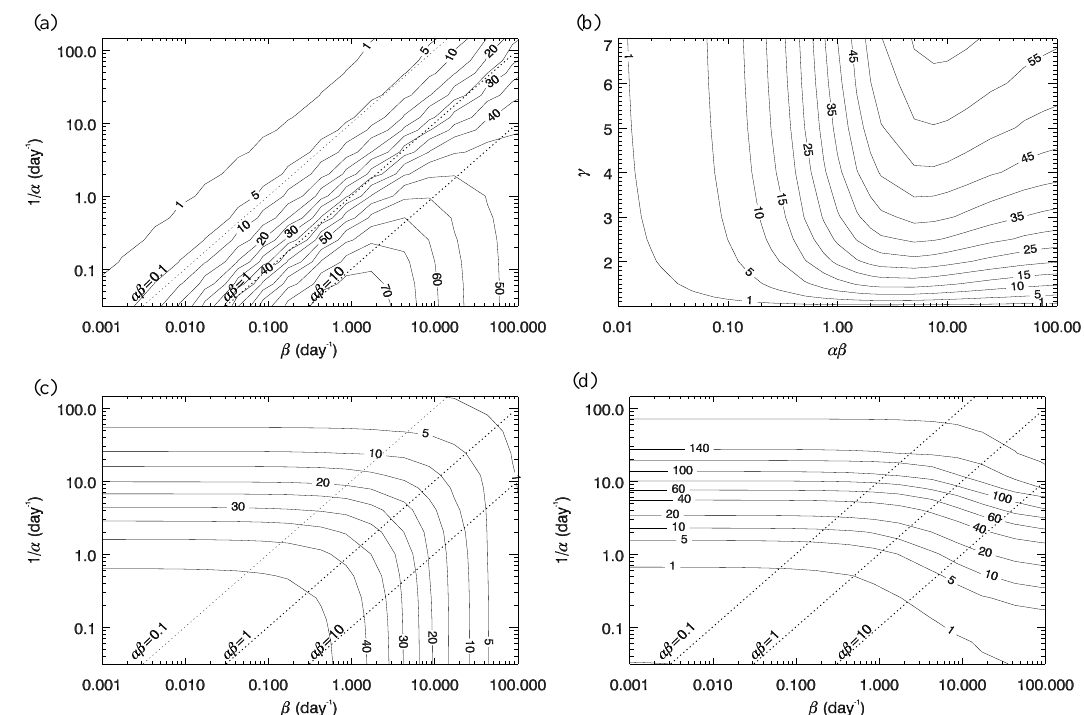
Figure 9. (a) Diurnally averaged tracer in the coastal outflow box (percentage of total domain tracer) as a function of decay rate 1 /α and advection rate β . (b) Diurnally averaged percentage of tracer in the coastal outflow layer as a function of αβ and BL-ratio γ for α = 1 day. (c) Diurnal average of tracer in the residual layer above land ( M 3 /(M 1 + M 3 ) ) as a function of 1 /α and β . (d) Diurnal variability of tracer (diurnal range divided by diurnal mean) as a function of 1 /α and β . In (a) , (c) and (d) the BL-ratio is constant, γ =5. Long-lived tracers are represented by αβ > 10, short-lived tracers are represented by αβ < 0 . 1.